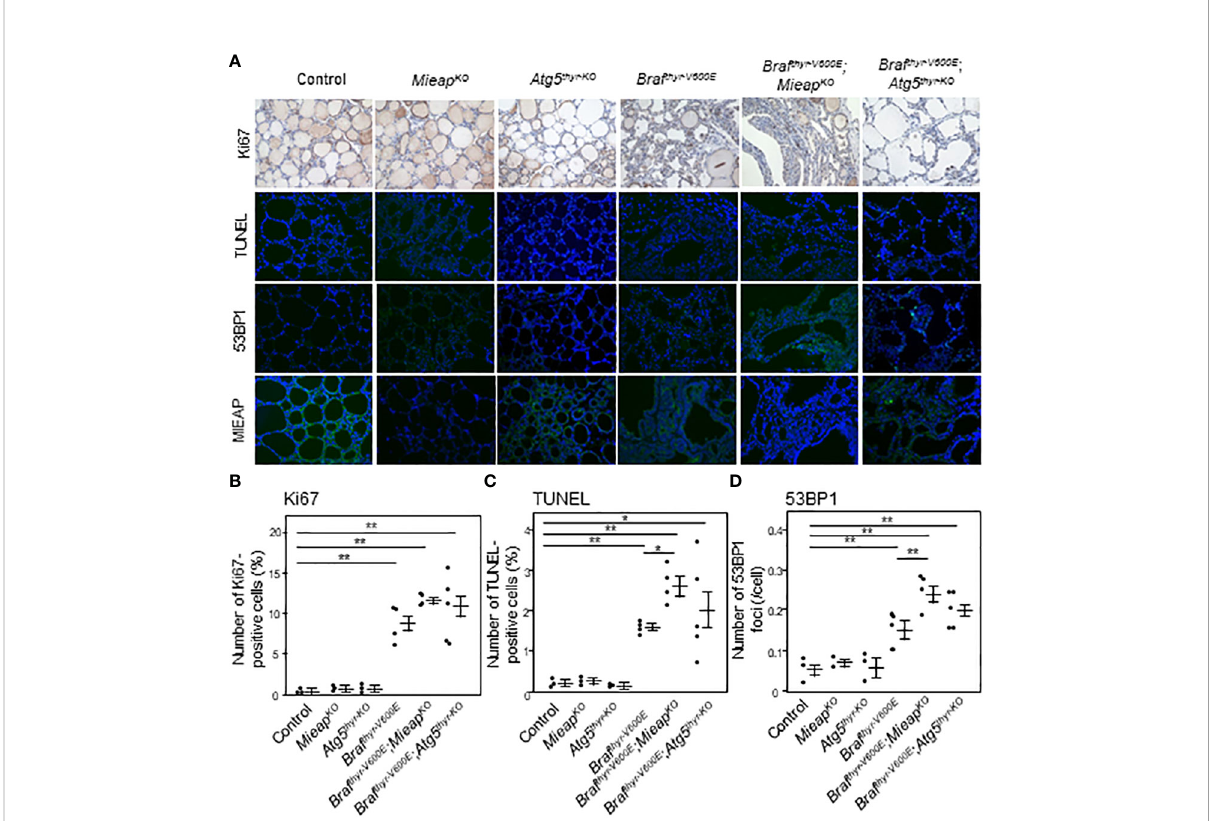
FIGURE 3 IHC staining for Ki67, TUNEL, 53BP1, and MIEAP expression (A) and quanti fi cation of Ki67 – positive cells (B) , TUNEL – positive cells (C) , and 53BP1 foci (D) in the thyroids from control, Mieap KO/KO , Atg5 thyr – KO/KO , Braf thyr – V600E , Braf thyr – V600E , Mieap KO/KO , and Braf thyr – V600E , Atg5 thyr – KO/KO mice at 12 months. The thyroid tissues obtained in Figure 1 were used for IHC as described in Materials and methods . The original magni fi cations were ×400. Data are shown as black circles for individual mice and as means ± SE. * P < 0.05, ** P < 0.01. M,